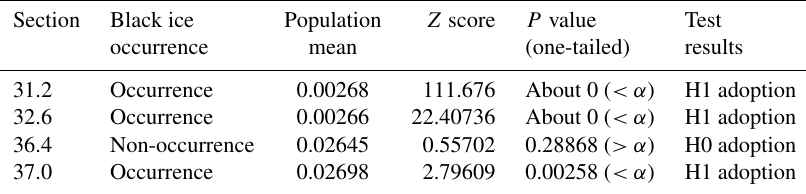
Figure 10. The location of occurrence of black ice (top two levels) and data collection results for each sensor. Points 31.2, 32.6, and 37.0 are the experimental group, and point 36.4 is the comparison group. (a) Data graph of the round force sensor. (b) Data graph of the water pressure sensor. (c) Data graph of ultrasonic sensor. (d) Average temperature from temperature–humidity sensor. (e) Average humidity from temperature–humidity sensor (source: Esri, Maxar, Earthstar Geographics, and the GIS user community). Table 6. Z -test (upper-tailed test) result of round force sensor data value. Section Black